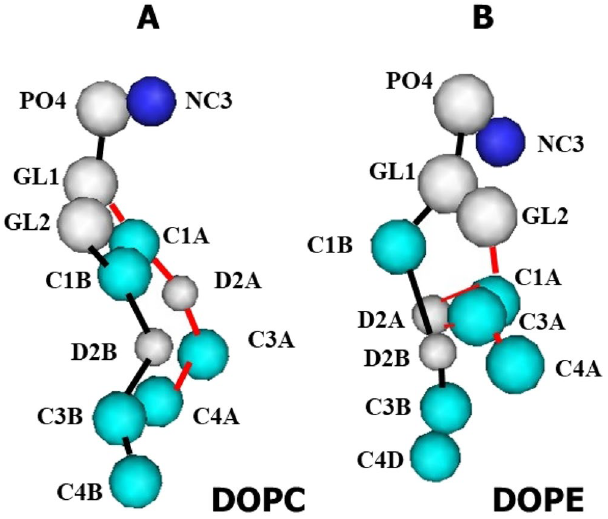
Figure 2. The coarse-grain structure of DOPC and DOPE phospholipids. ( A ) DOPC phospholipid: have beads of NC3 (blue), PO4, GL1, GL2, D2A, and D2B (milky color), C1A, C1B, C3A, C4A, C3B, and C4B (turquoise blue). ( B ) DOPE phospholipid: have beads of NC3 (blue), PO4, GL1, GL2, D2A, and D2B (milky color), C1A, C1B, C3A, C4A, C3B, and C4D (turquoise